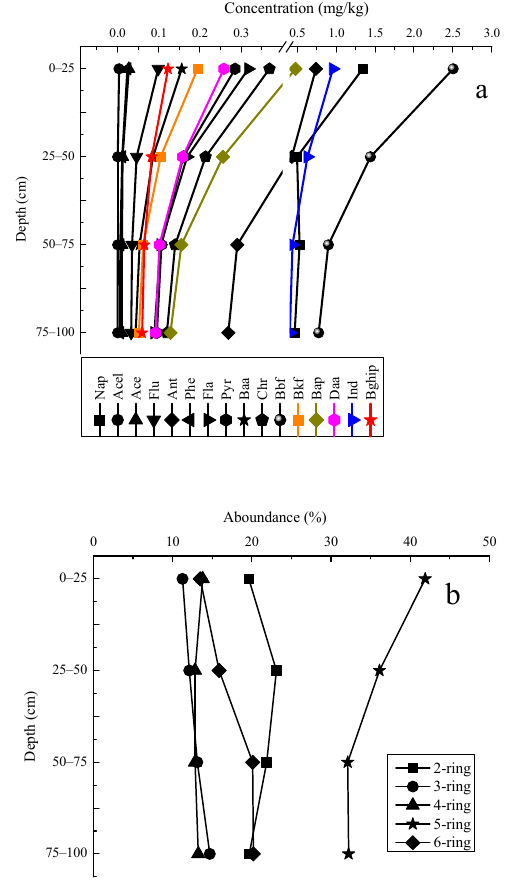
Figure 4. Concentration distributions in the vertical sections of ( a ) individual PAHs and ( b ) individual PAHs grouped by ring numbers in the soil profiles around the chemical plant area. Note: 2-ring: Nap; 3-ring: Ace, Acel, Flu, Phe, Ant; 4-ring: Fla, Pyr, Baa, Chr; 5-ring: Bbf, Bkf, Bap, Daa; 6-ring: Ind, Bghip.